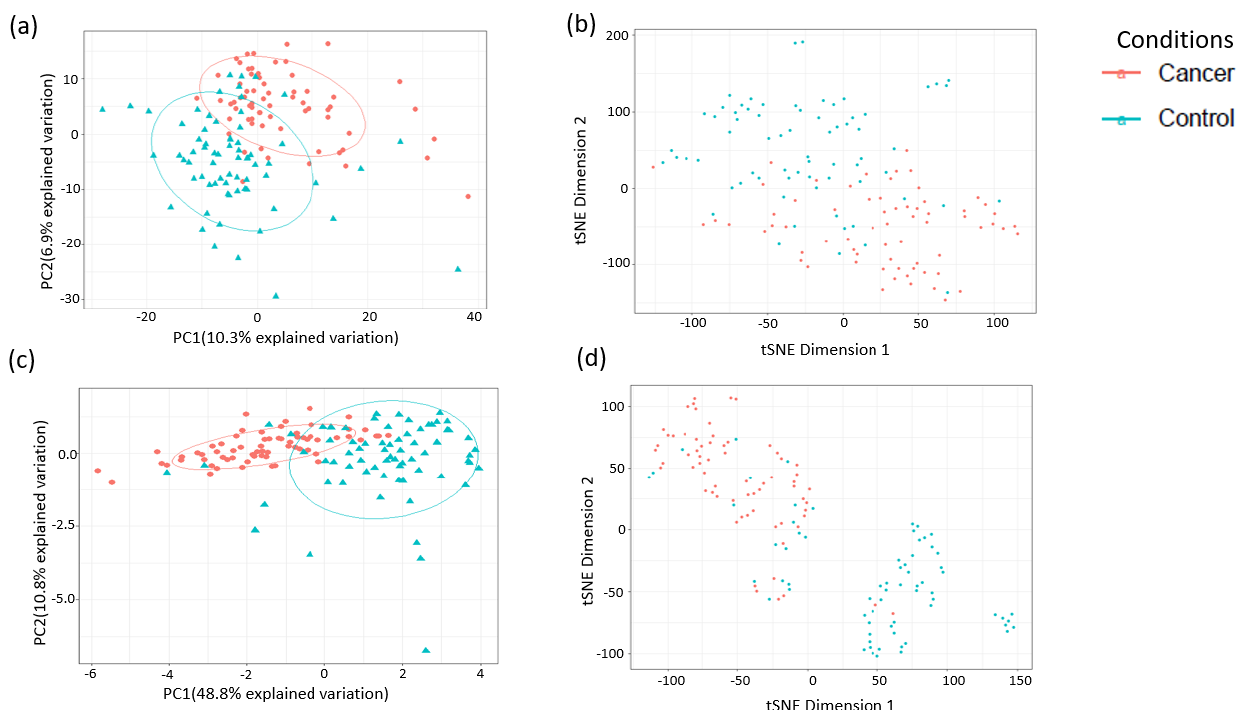
Figure 3. Analysis of sample separation using the training set ( n = 109, cancers = 54, controls = 55) based on principal component (PCA) ( a , c ) and t-distributed stochastic neighbour embedding (t-SNE) ( b , d ) analyses using all identified metabolites ( a , b ) and the top 10 discriminatory metabolites ( c , d ) identified by random forest machine learning technique. t-SNE (perplexity: 5, iteration: 10,000).